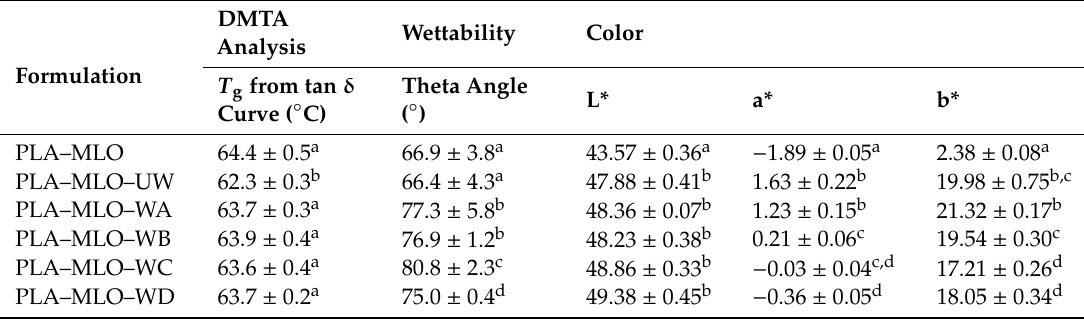
Table 3. T g temperature determined by dynamic thermo-mechanical analysis (DMTA) from tan δ , wettability and color measurement results of PLA–wool FRP